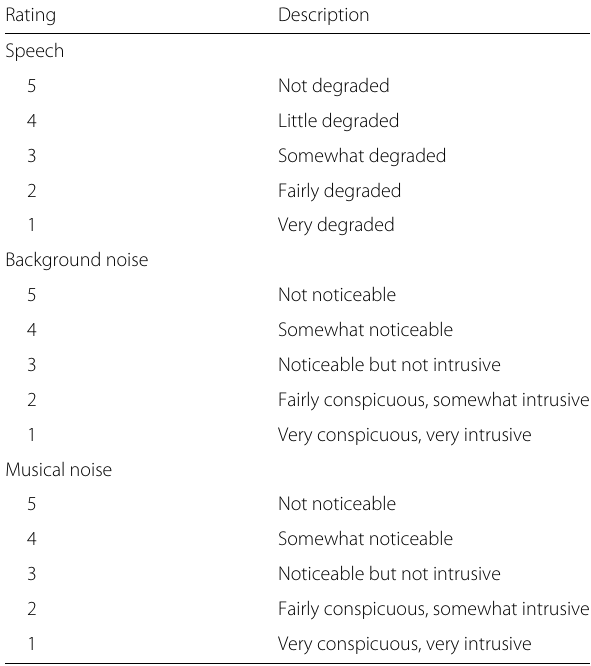
Table 1 Scale description of the listening test criteria [43]